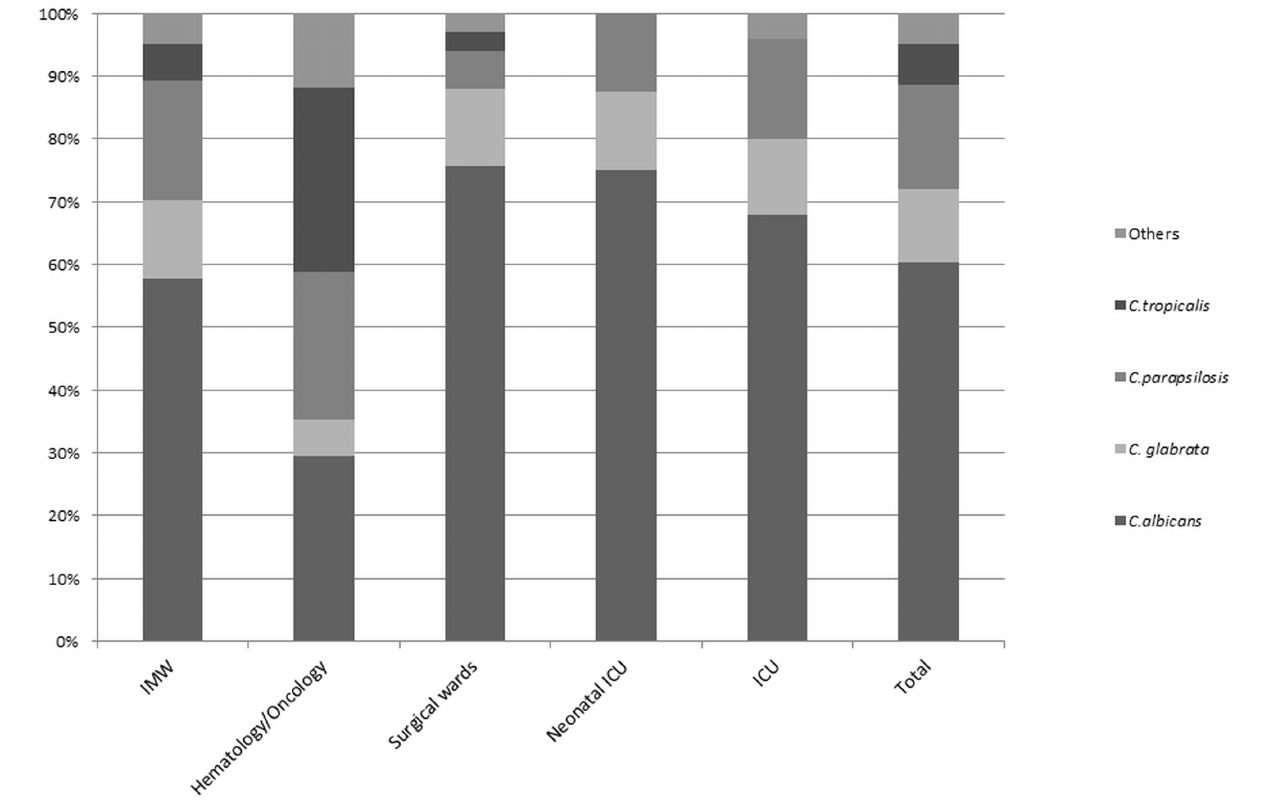
Fig 1. Candida spp. distribution expressed as percentage of total candida species in various hospital